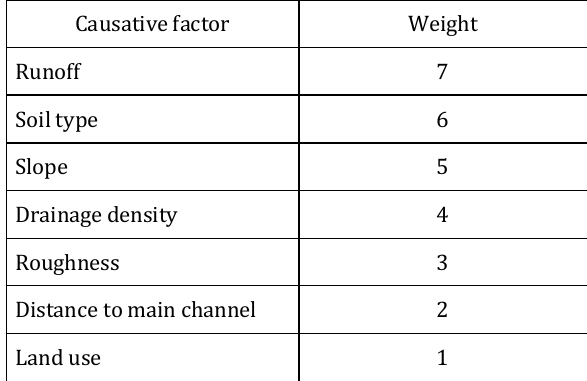
Table 4. Drainage factors and their corresponding weights